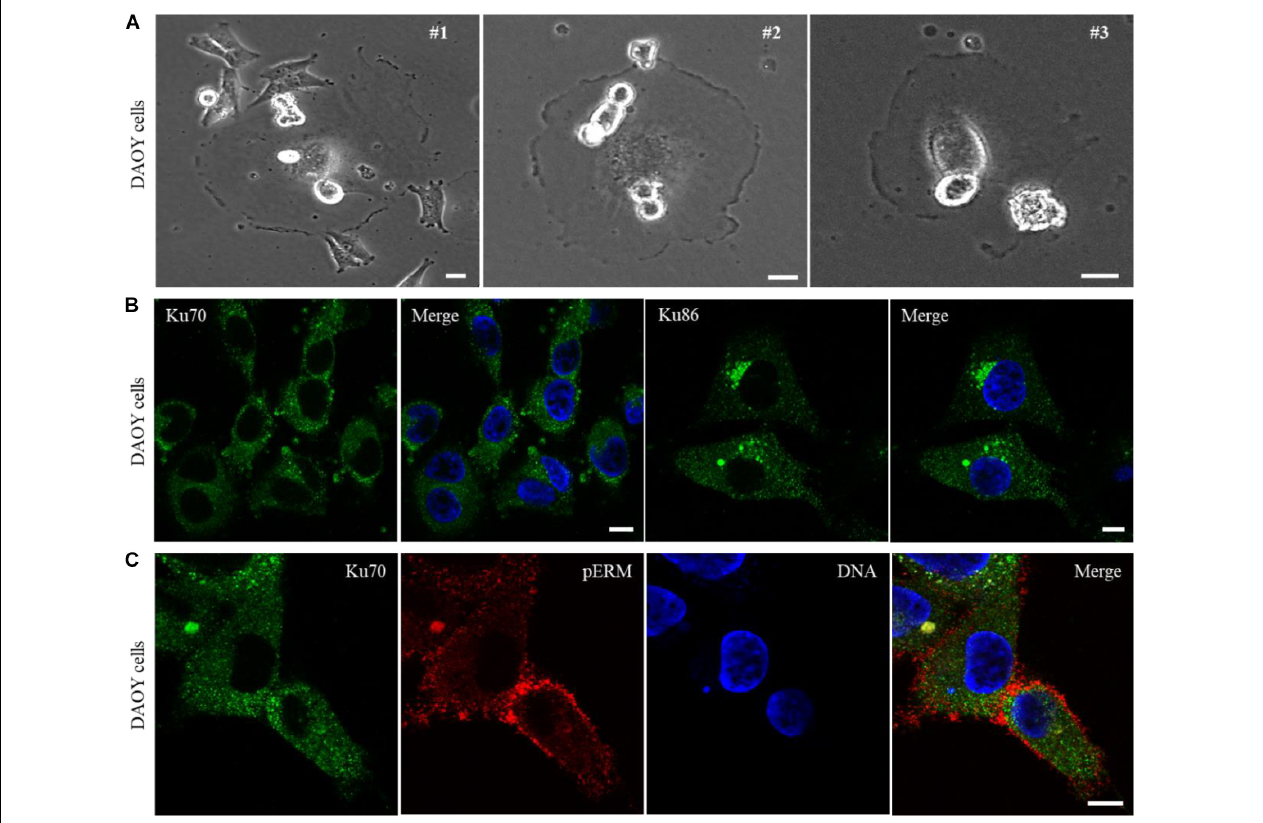
FIGURE 3 | DAOY cells derived from a desmoplastic cerebellar medulloblastoma show explicit exclusion of Ku70/Ku86 from cell nuclei. Light microscopy examination of DAOY cells shows wide-spread appearance of giant cells, with similar phenotypic features of Ku70-lacking HCT116 cells. DAOY cells showing a giant cell surrounded with the smaller size of cells (#1), the rounded/mitotic cells placed on the body of giant cells (#1, #2, #3), and the rounded/mitotic cells fused/penetrated into the giant cell membranes (#1, #2, #3) are shown in (A) . Scale bar, 20 µ m. Immunostaining of DAOY cells for Ku70 or Ku86 shows nuclear exclusion of Ku70/Ku86. Scale bar, 10 µ m (B) . DAOY cells were immuno-stained for Ku70 and pERM, and an example of “attacking cell” with a surrounding condensed pERM signal is shown (C) . Scale bar, 10 µ